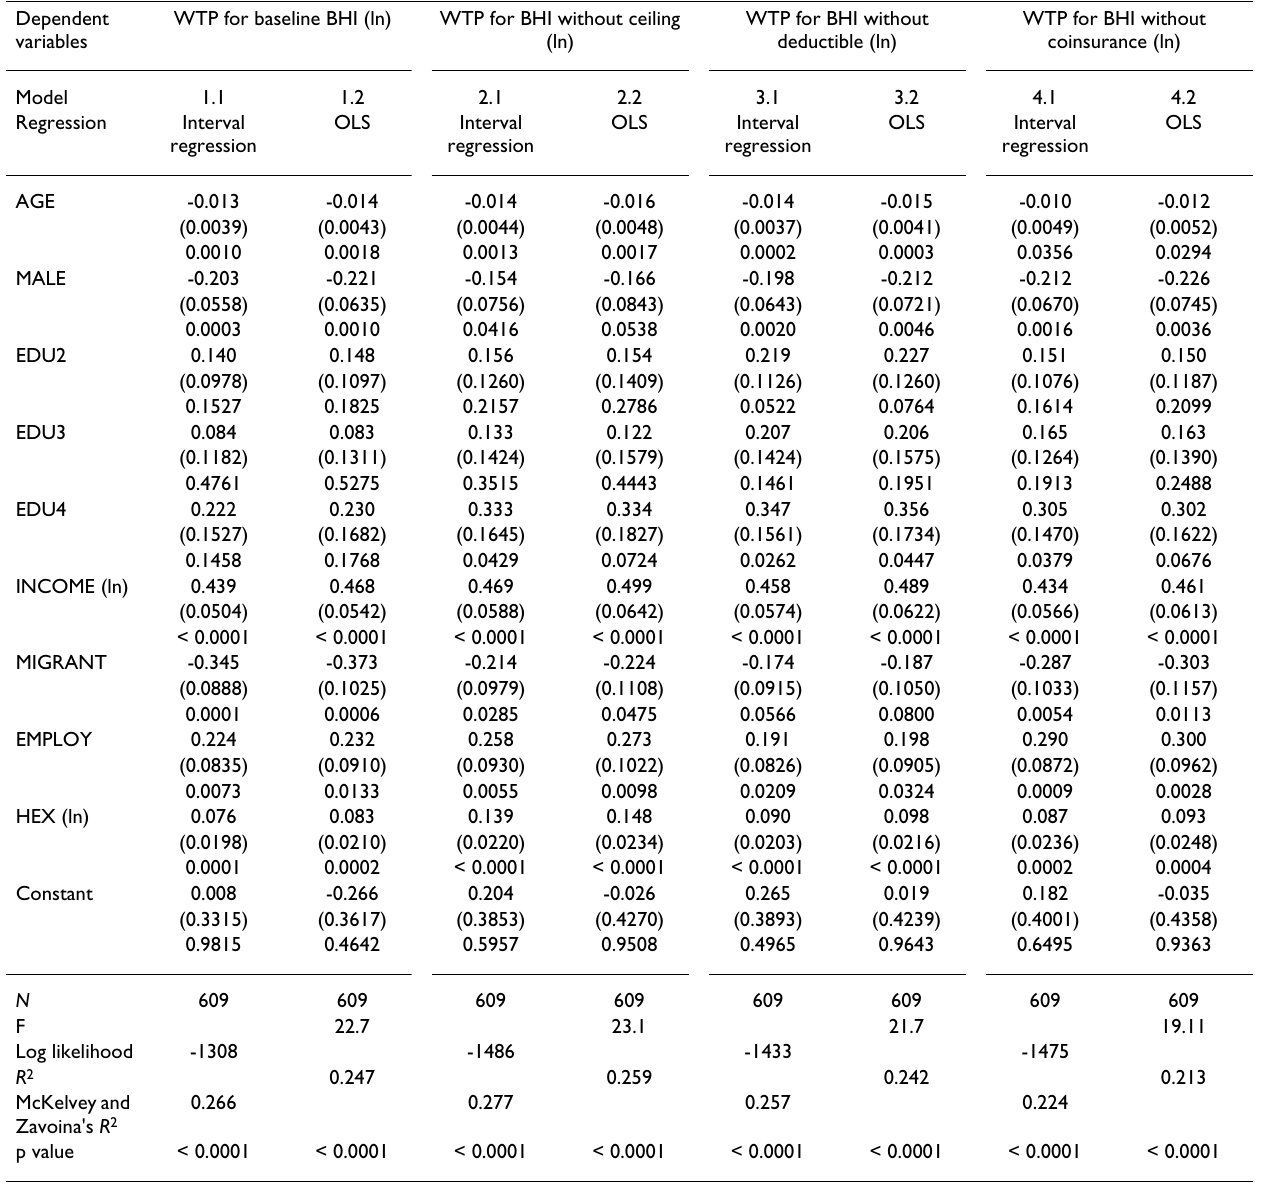
Table 5: Determinants of willingness to